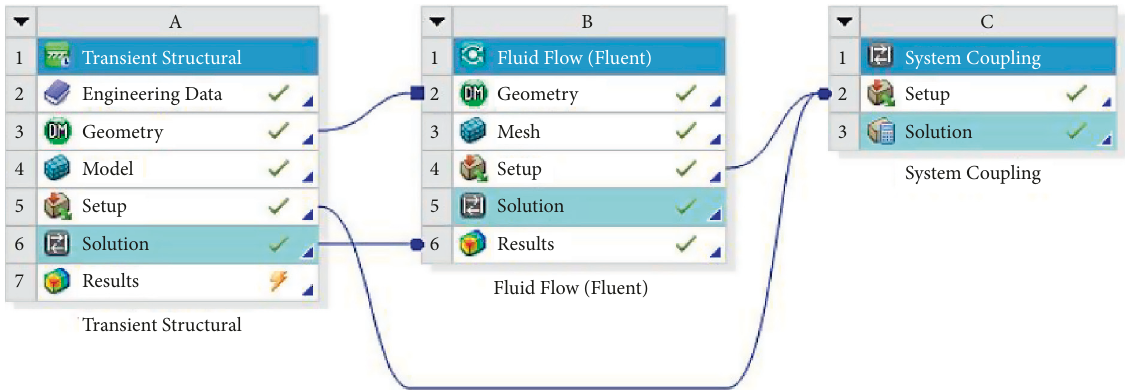
Figure 2: System coupling for FSI simulation.